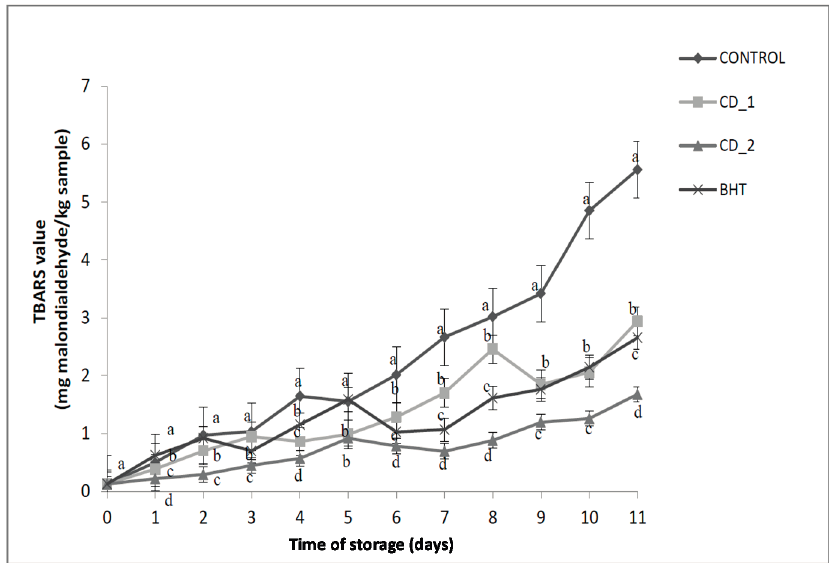
Figure 4. Effects of two concentrations of Caesalpinia decapetala added at 0.1% and 0.5% ( w / w ) and BHT added at 0.01% ( w / w ) on TBARS value (mg of malondialdehyde equivalent/kg of sample) of raw beef patties during 11 days of refrigerated storage at 4 °C. Results are given as mean ± standard error. Different letters in the same day (a–d) indicate